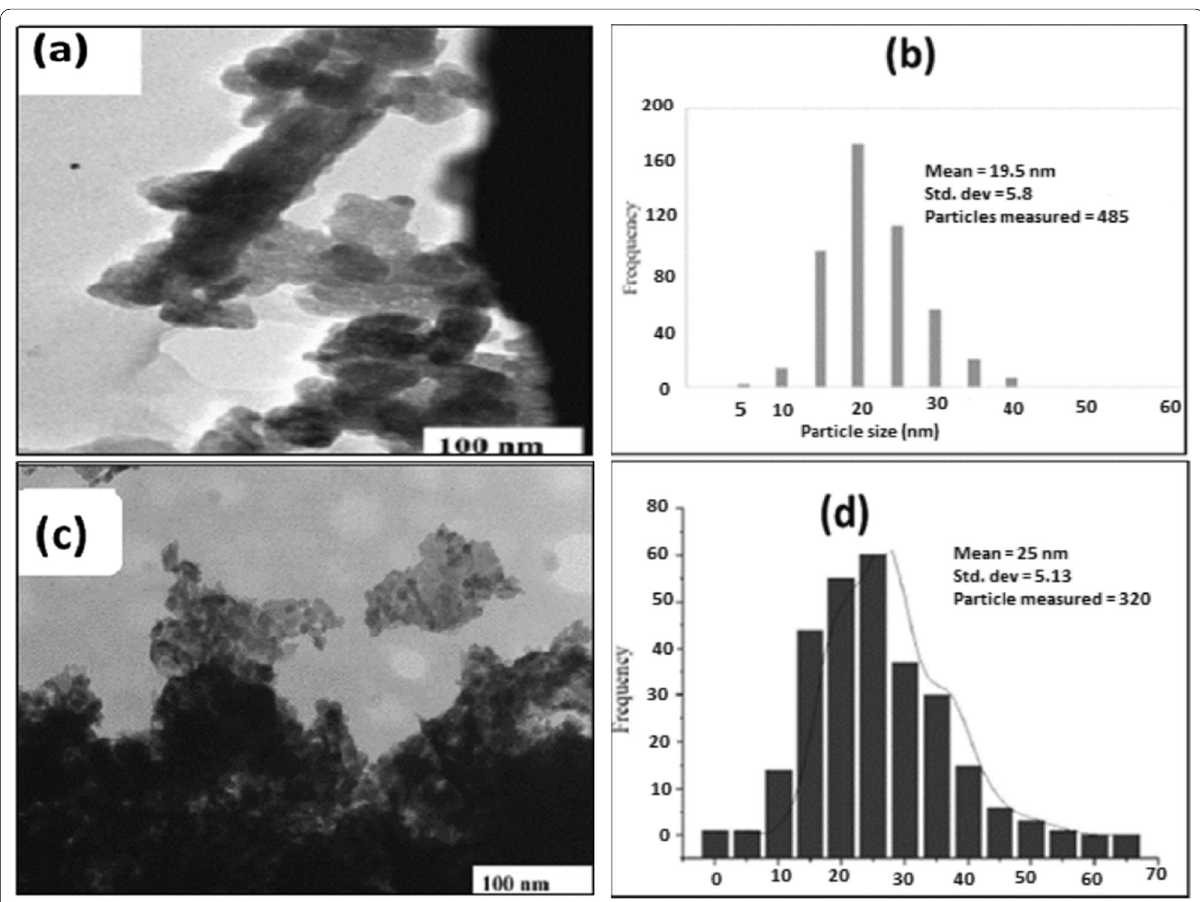
Fig. 4 TEM Images and particle size distribution histogram of ZnONPs synthesized using H. aureonitens extract ( a , b ) and flavone ( c , d